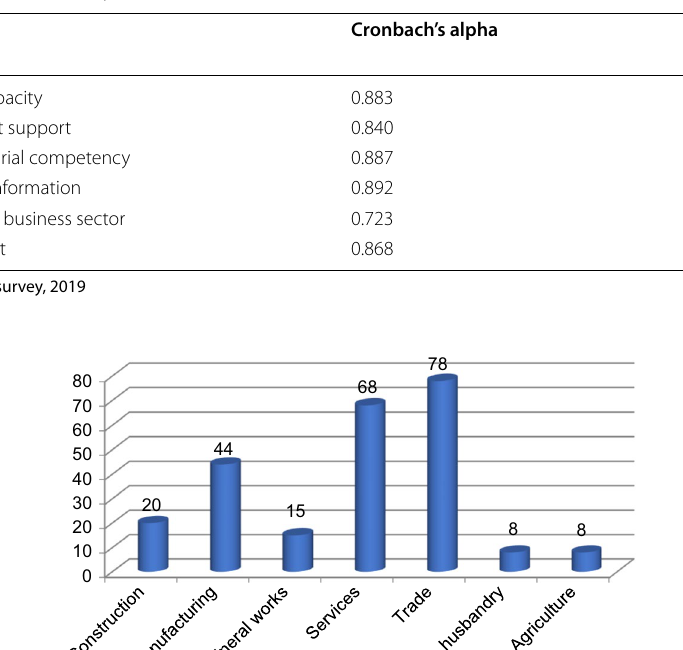
Table 1 Cronbach’s alpha coefficient test